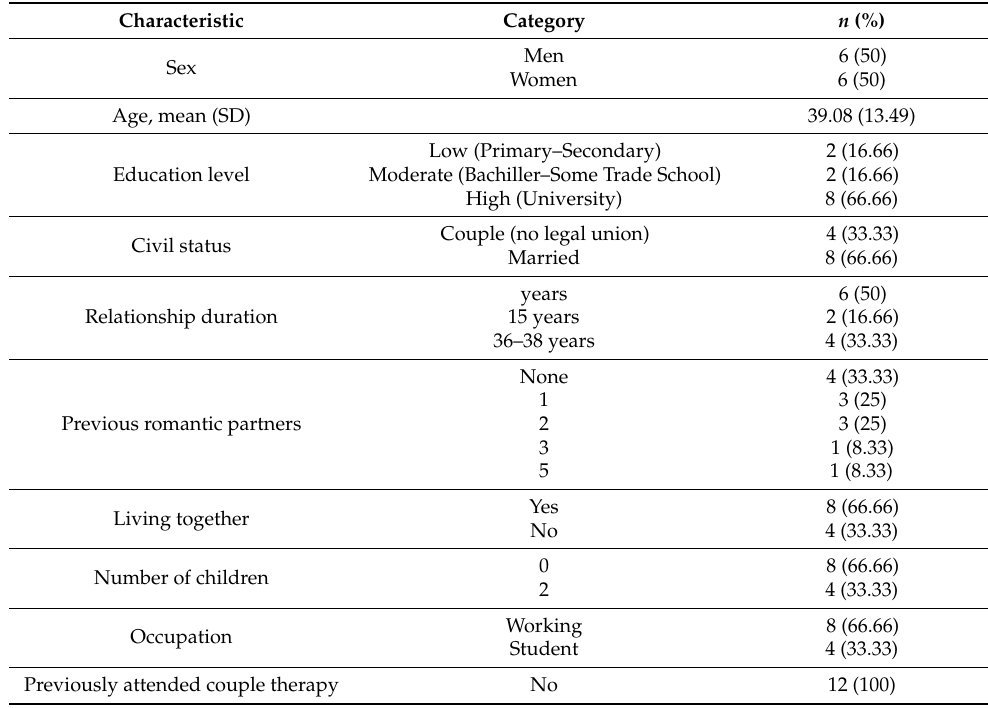
Table 1. Sociodemographic characteristics of participants ( n =